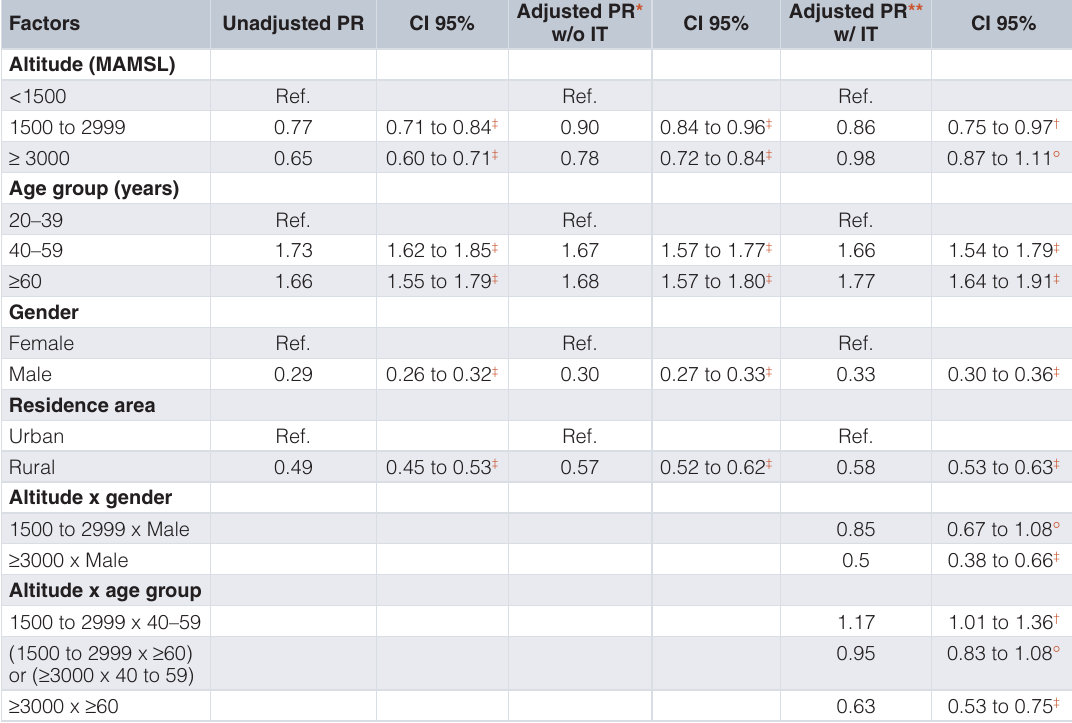
Table 5. Factors associated with abdominal obesity (by ATP III) in